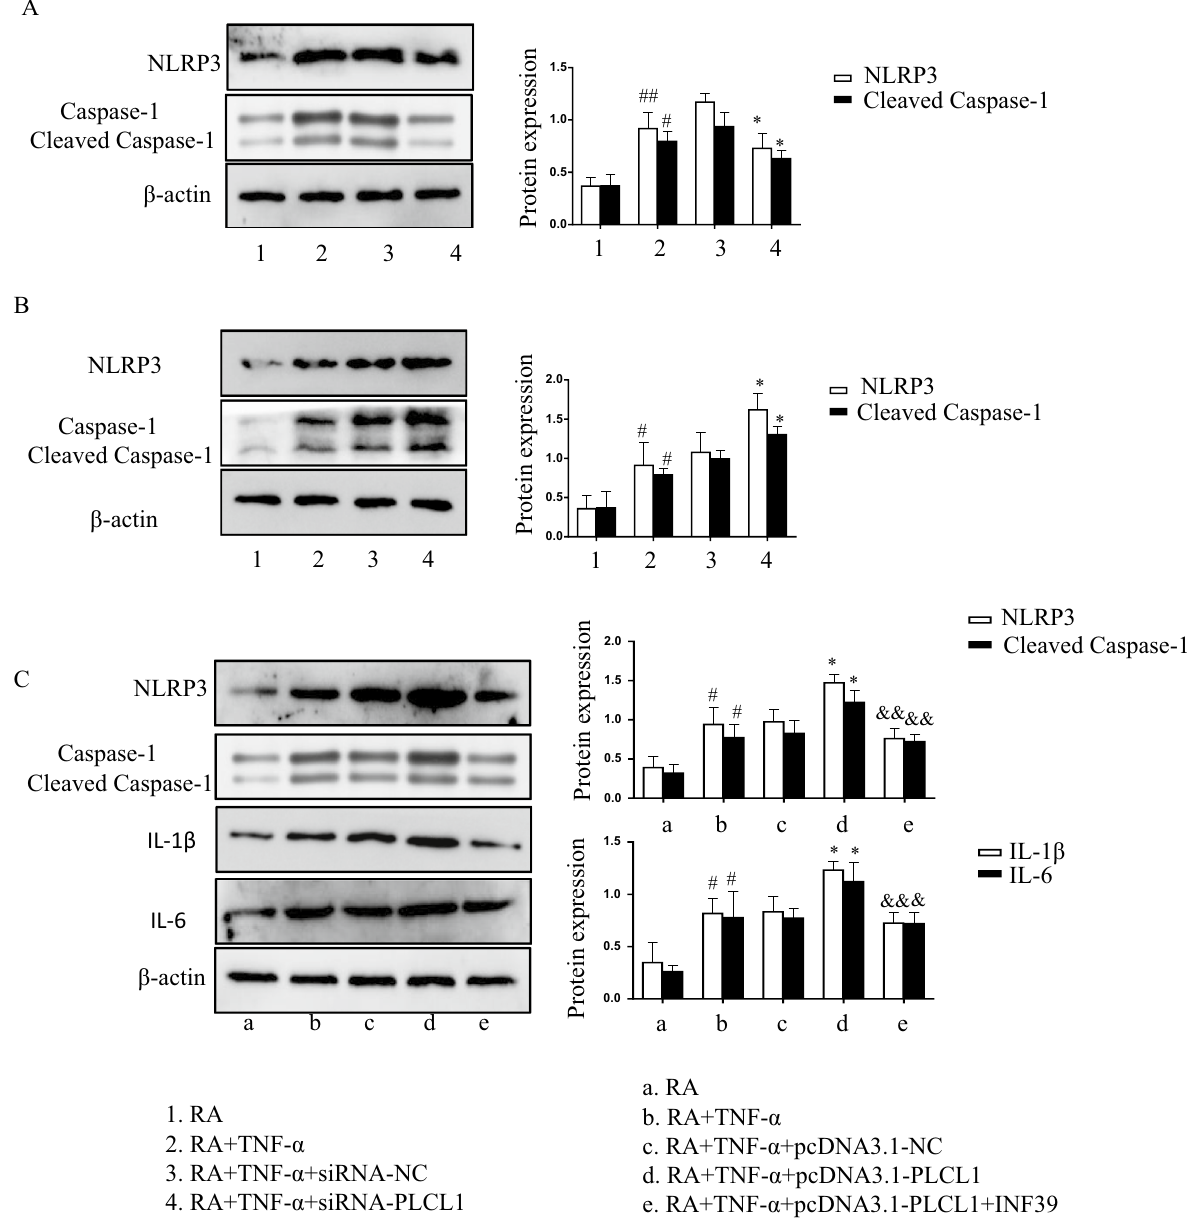
Fig. 5 PLCL1 plays an important function under the regulation of the NLRP3 inflammasomes. a The level of NLRP3 protein and Caspase‑1/Cleaved Caspase‑1 protein in 10 ng/ml TNF‑α‑incubated RA FLS were analyzed by WB after using PLCL1siRNA. b The protein level of NLRP3 and Caspase‑1/ Cleaved Caspase‑1 were analyzed by WB in 10 ng/ml TNF‑α‑incubated RA FLS after using PLCL1 overexpression plasmids. c WB was used to detect NLRP3, Caspase‑1/Cleaved Caspase‑1, IL‑6 and IL‑1β protein levels in 10 ng/ml TNF‑α‑incubated RA FLS after using PLCL1 overexpression plasmids and NLRP3 inhibitor INF39. (Compared with the RA group # P < 0.05, ## P < 0.01; compared with the negative control group * P < 0.05, ** P < 0.01; compared with the PLCL1 overexpression group & P < 0.05, && P <